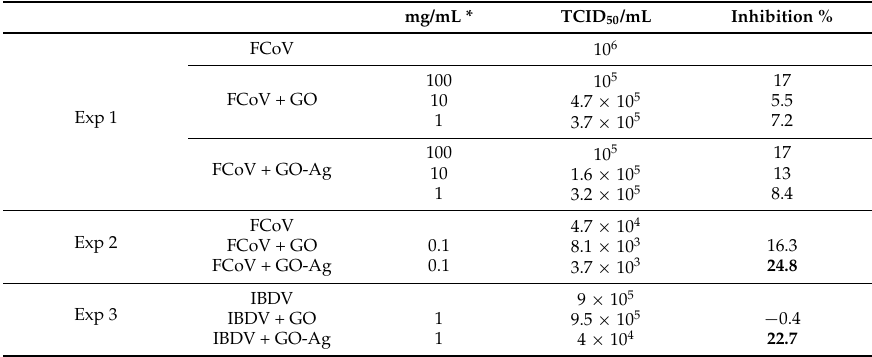
* Concentration of GO or GO-Ag in mg/mL. Inhibition % = (log 10 (TCID 50 /mL of virus) − log 10 (TCID 50 /mL of treatment))/log 10 (TCID 50 /mL of virus) × 100%; FCoV: feline coronavirus; GO: graphene oxide; GO-Ag: graphene oxide with Ag particles; IBDV: infectious bursal disease virus.